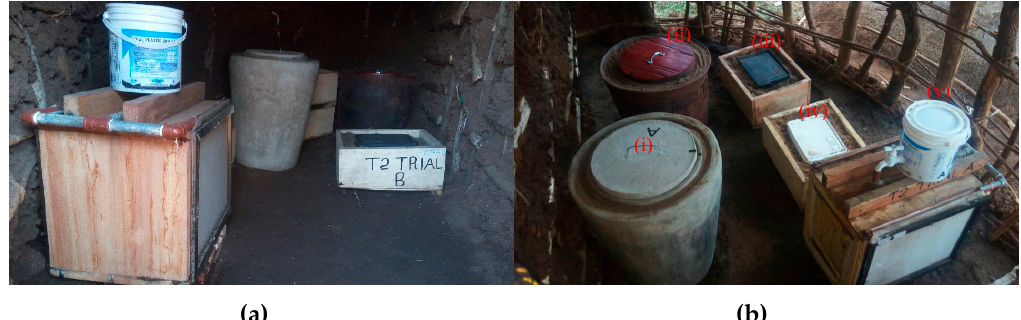
Figure 1. Passive cooling device (PCD) designs stored indoors ( a ) and outdoors ( b ). The different PCDs are labeled as follows: (i) Zeepot cementsand, (ii) Zeepot Clay, (iii) Coolbox sand, (iv) Coolbox sawdust and (v) Coolgardie.